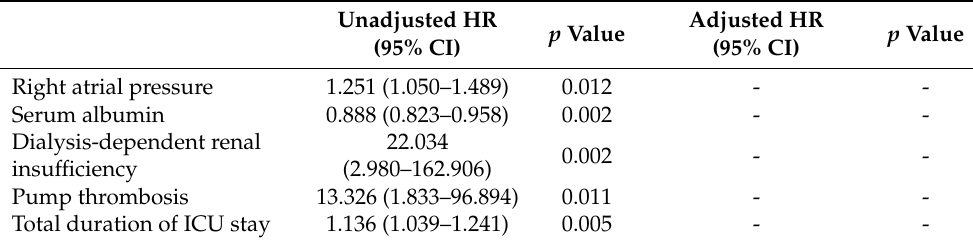
Table 4. Predictors of late RHF development.